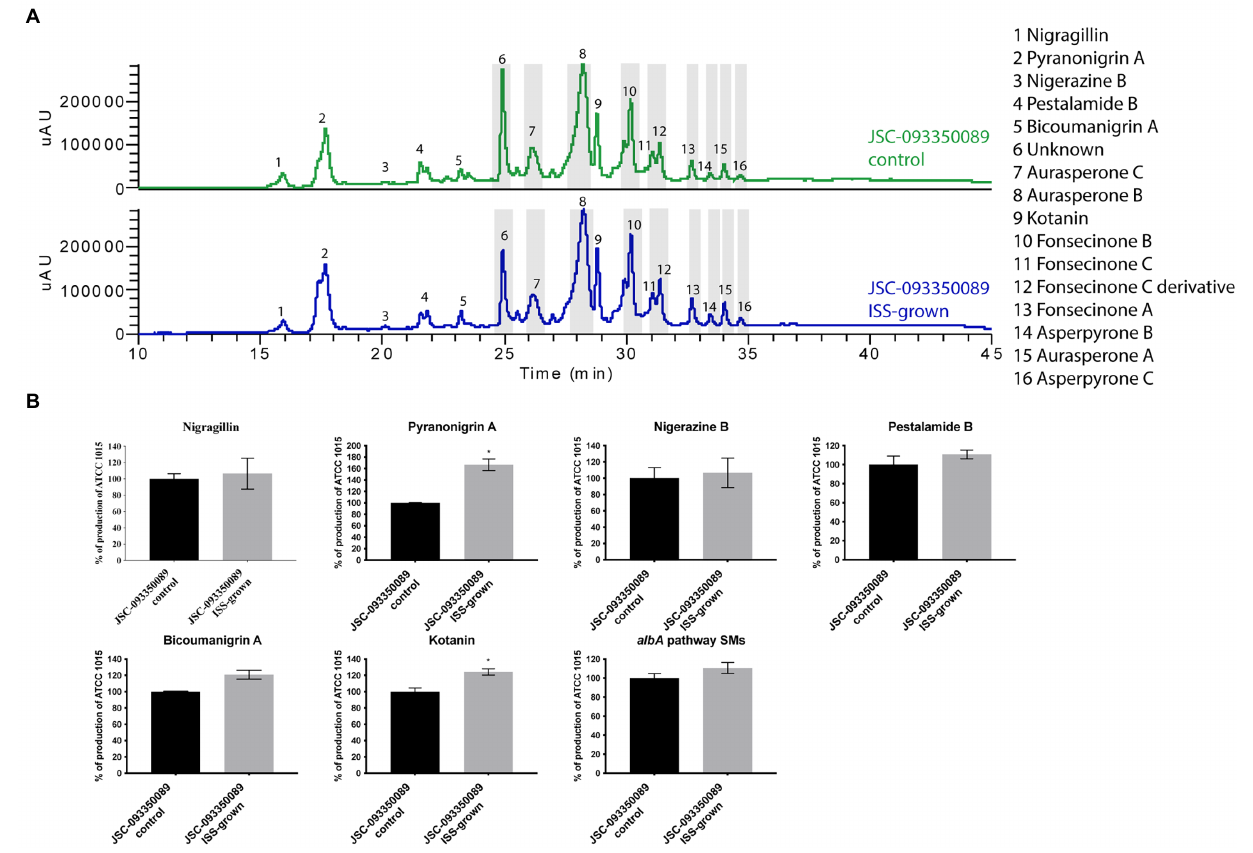
FIGURE 3 | Secondary metabolite production of regrown ISS- and ground-grown JSC-093350089. (A) Secondary metabolite profiles of regrown ISS- and ground- grown JSC-093350089 when grown on GMM. (B) Metabolite quantification showing the percent change for each metabolite in relation to regrown ground-grown JSC-093350089; significance was determined using Welch’s t-test. “*” means and indicates statistical